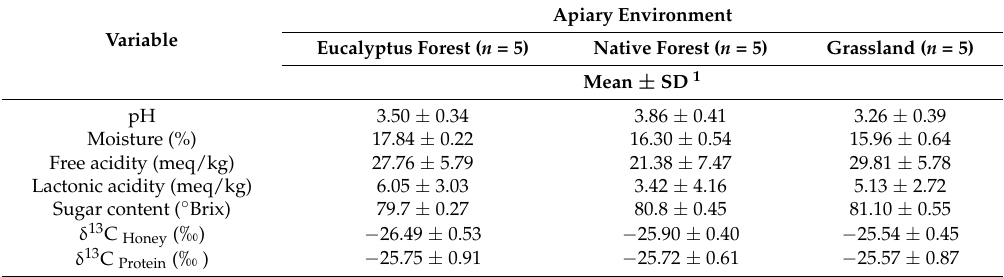
Table 1. Mean physicochemical properties of honey samples grouped by environmental origin.